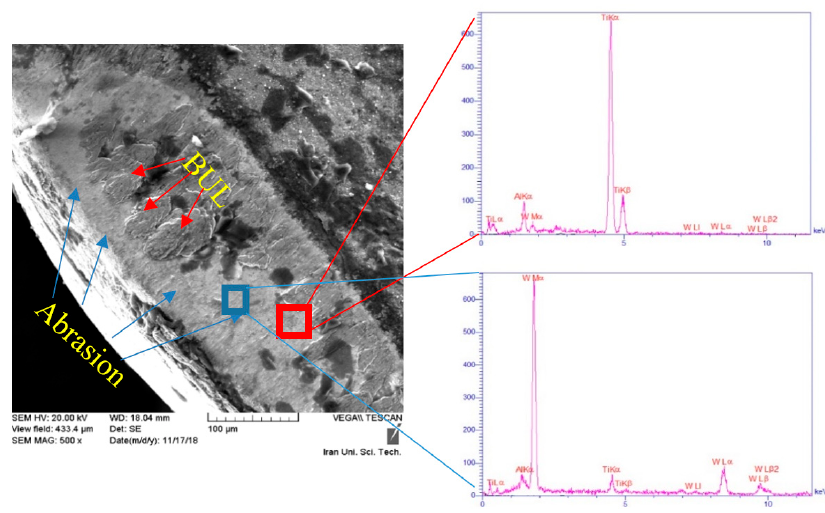
Figure 9. Wear modes on the rake face of insert TS2000 after 120 s of cutting.